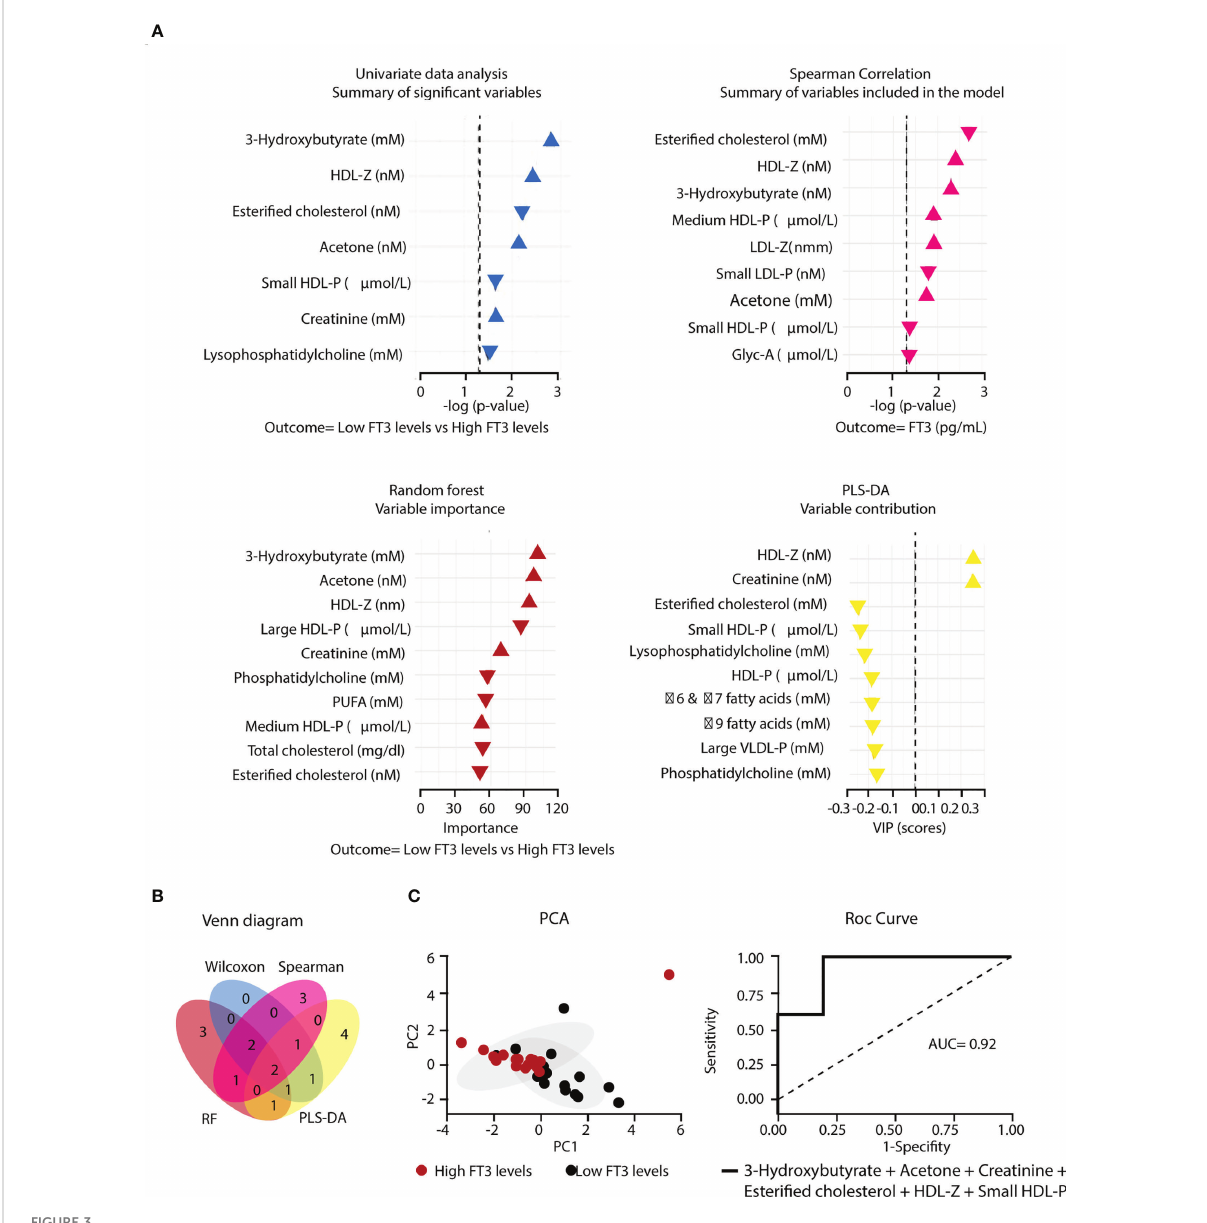
FIGURE 3 Metabolomic cluster associated to low FT3 in COVID-19 ward hospitalized patients. (A) Variables differently expressed in the low-FT3 group (n=18) and high-FT3 group (n=17) determined by four different methods. (B) Venn diagram describing the overlapping metabolomic parameters from the 4 statistical models. (C) PCA based on two principal components using the metabolomic cluster resulting from the previous steps, and Roc curve showing the accuracy (AUC). Gly, Glycoprotein; P, Particles; PUFA Polyunsaturated fatty acids (four PUFA signals); w , Omega; Z,